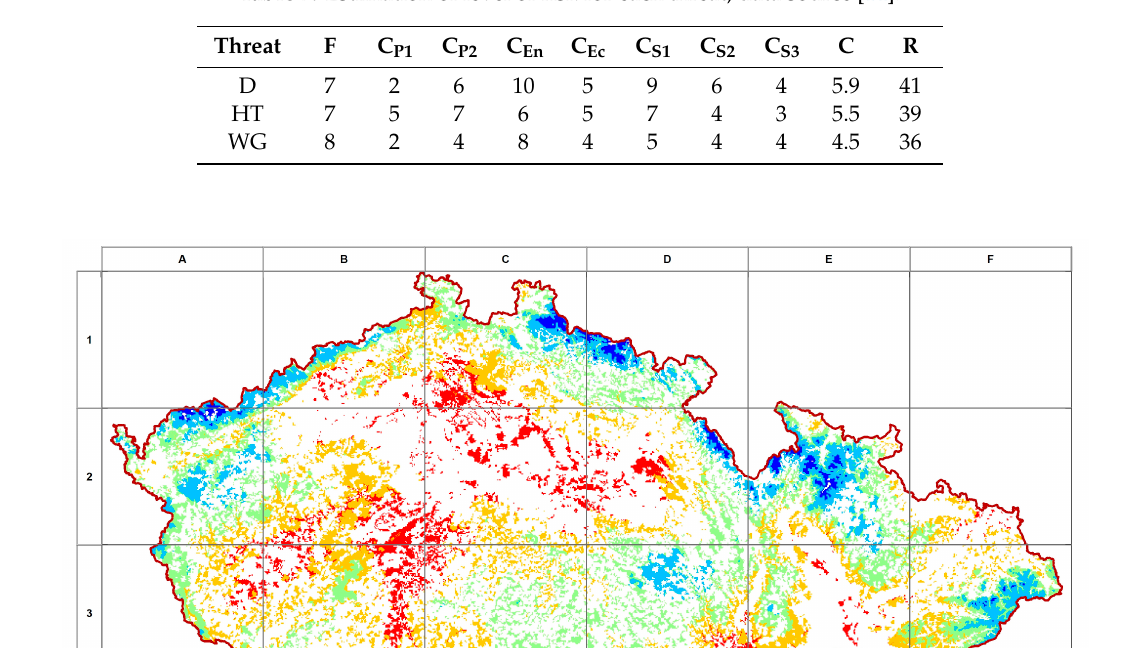
Table 7. Estimation of level of risk for each threat; data source [14].